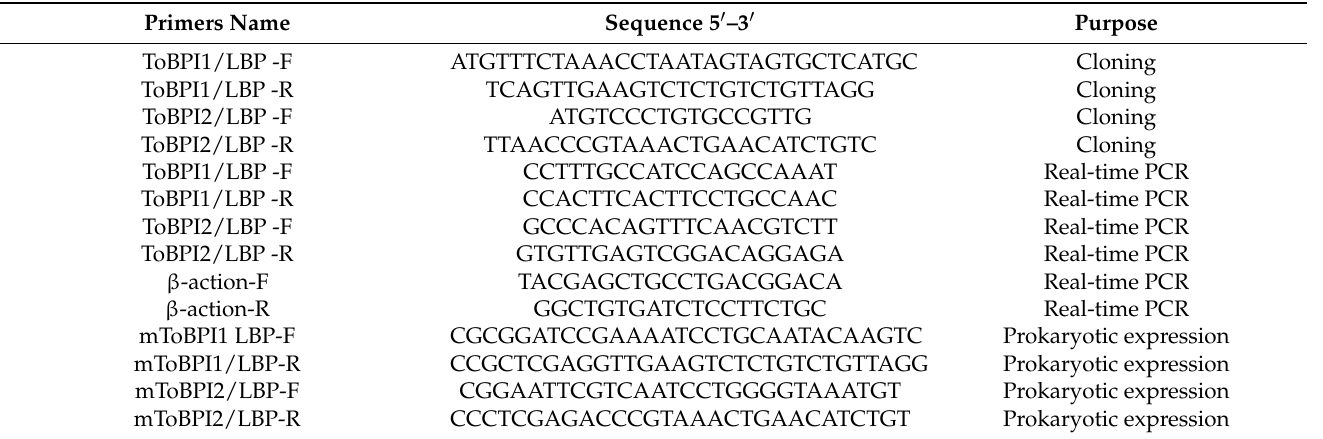
Table 1. Primers used in this